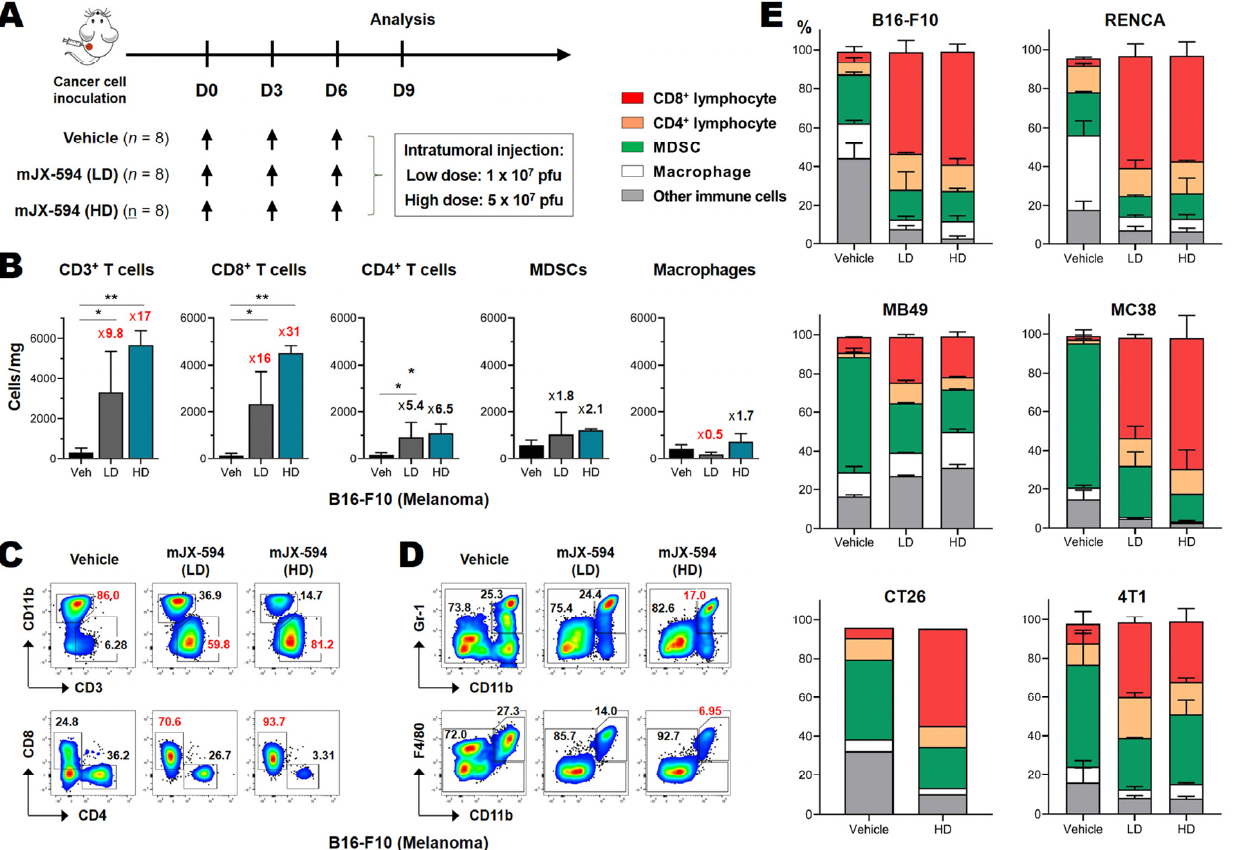
Figure 2. Profound CD8 + T cell activation and decreased expression of suppressive myeloid cells by mJX-594. ( A ) mJX-594 treatment strategy. Cancer cells were implanted subcutaneously into C57BL/6 and BALB/c mice. When the tumor reached a volume of 50–60 mm 3 , mice were intratumorally injected, three times at 3-day intervals, with vehicle, 1 × 10 7 pfu of mJX-594 (LD), or 5 × 10 7 pfu of mJX-594 (HD). The tumor-infiltrating leukocytes were analyzed 3 days after the last treatment with mJX-594. ( B ) The numbers of CD3 + T cells, CD8 + T cells, CD4 + T cells, MDSCs, and macrophages per milligram of tumor mass among infiltrated leukocytes of B16-F10 melanoma. ( C ) Flowcytometric analysis and gating strategies for CD3 + T cells and CD11b + myeloid cells among infiltrated leuko- cytes (upper) and CD8 + T cells and CD4 + T cells among infiltrated CD3 + cells (lower) of B16-F10 melanoma. ( D ) Flowcytometric analysis and gating strategies for MDSCs (CD11b + Gr-1 + ) (upper) and macrophages (F4/80 + CD11b + ) (lower) among infiltrated leukocytes of B16-F10 melanoma. ( E ) Summarized relative proportions of CD8 + lymphocyte, CD4 + lymphocyte, MDSC, macrophage, and other immune cells among infiltrated leukocytes of B16-F10, RENCA, MB49, MC38, CT26, and 4T1 tumors. Pooled data from two experiments are shown ( n = 6 per group). * p < 0.05, ** p < 0.005. MDSC, myeloid-derived suppressor cells; mJX, mJX-594; OVA, ovalbumin; pfu, plaque-forming units; Veh, vehicle.